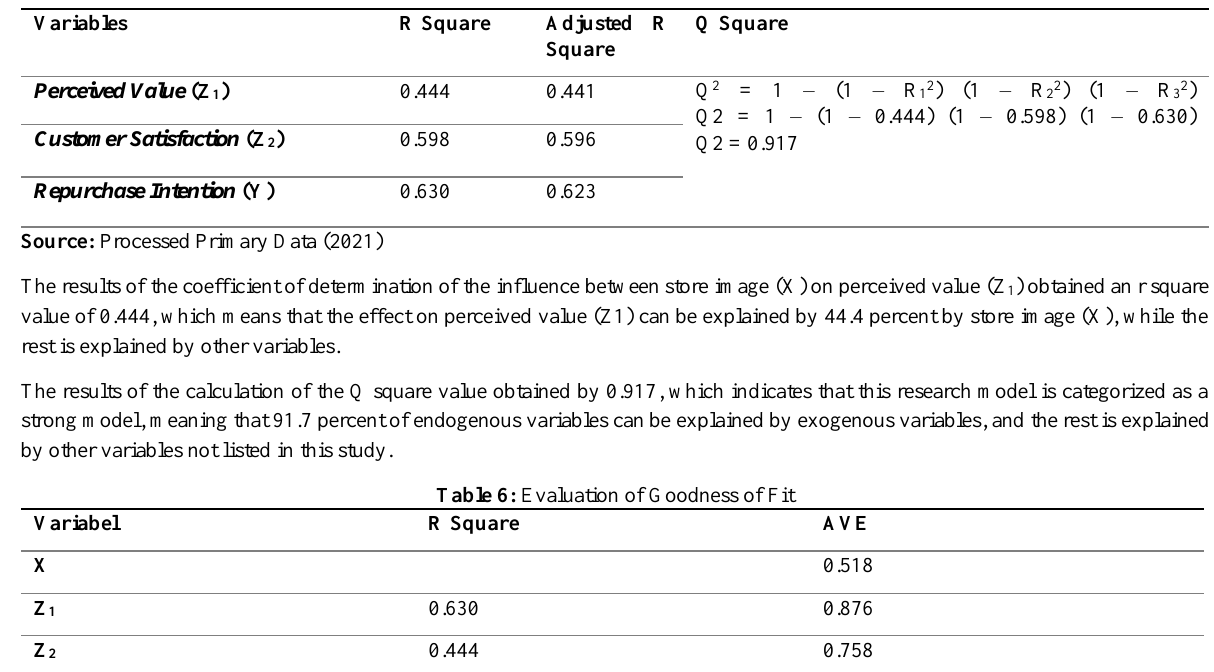
Table 5: Results of the Coefficient of Determination